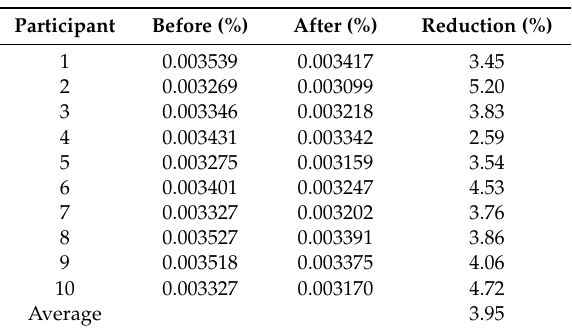
Table 4. MSI results.